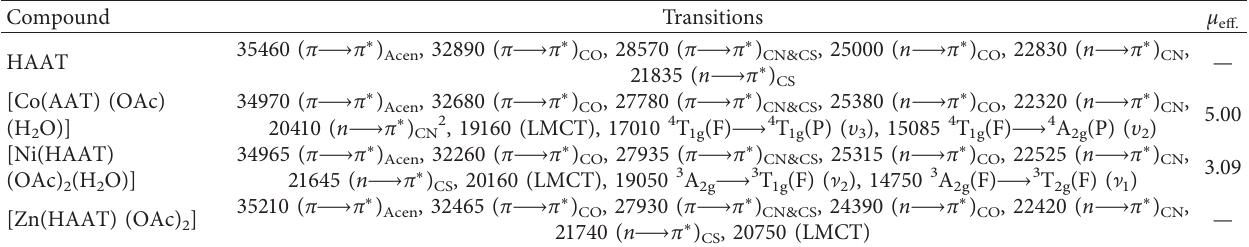
Table 3: Electronic spectral date of AATH and its metal complexes. Compound Transitions